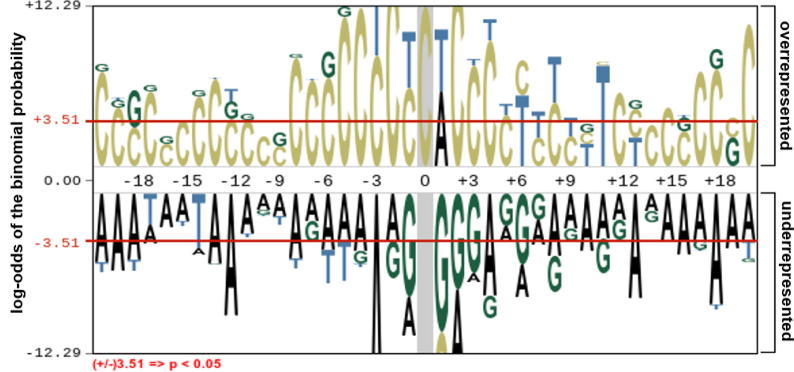
Sequence logo representation of 4mC samples. The 20 upstream and 20 downstream DNA residues surrounding the mouse 4mC site were analyzed.